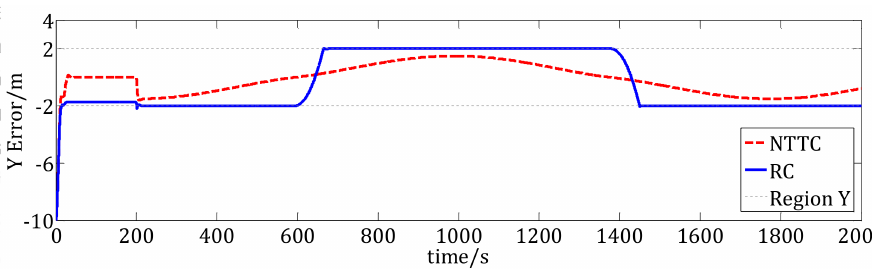
Figure 8. Position tracking errors in Y direction.